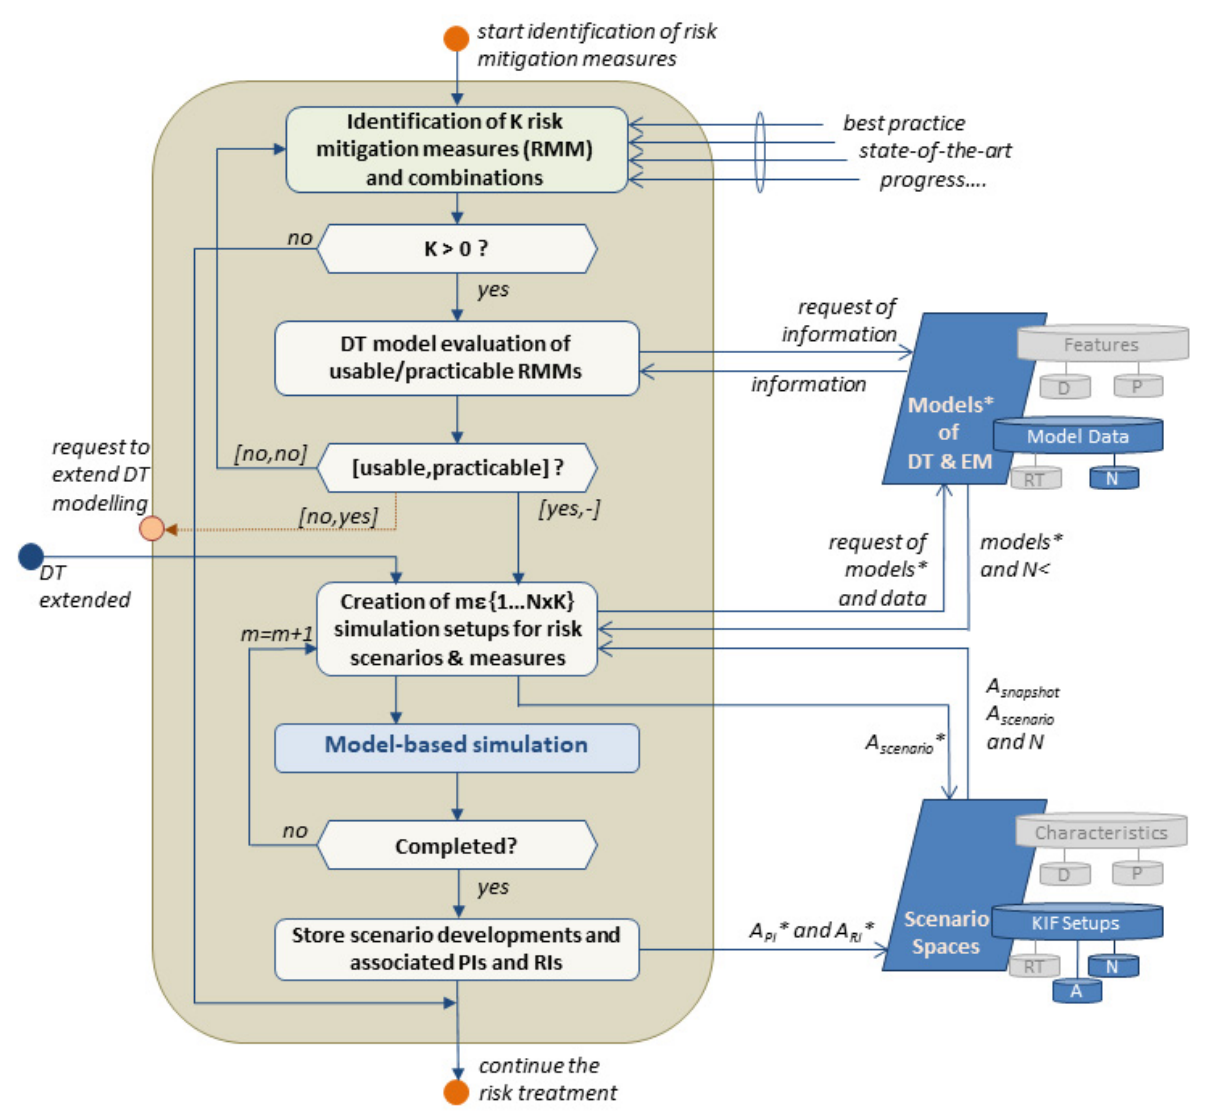
Figure 10. Flow chart of identification of risk mitigation measures.